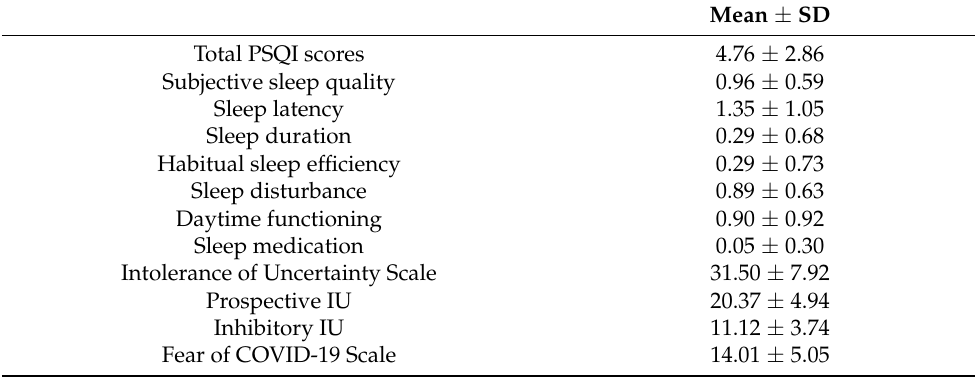
Table 2. Degree among PSQI, Intolerance of Uncertainty, and Fear of COVID-19 ( N =